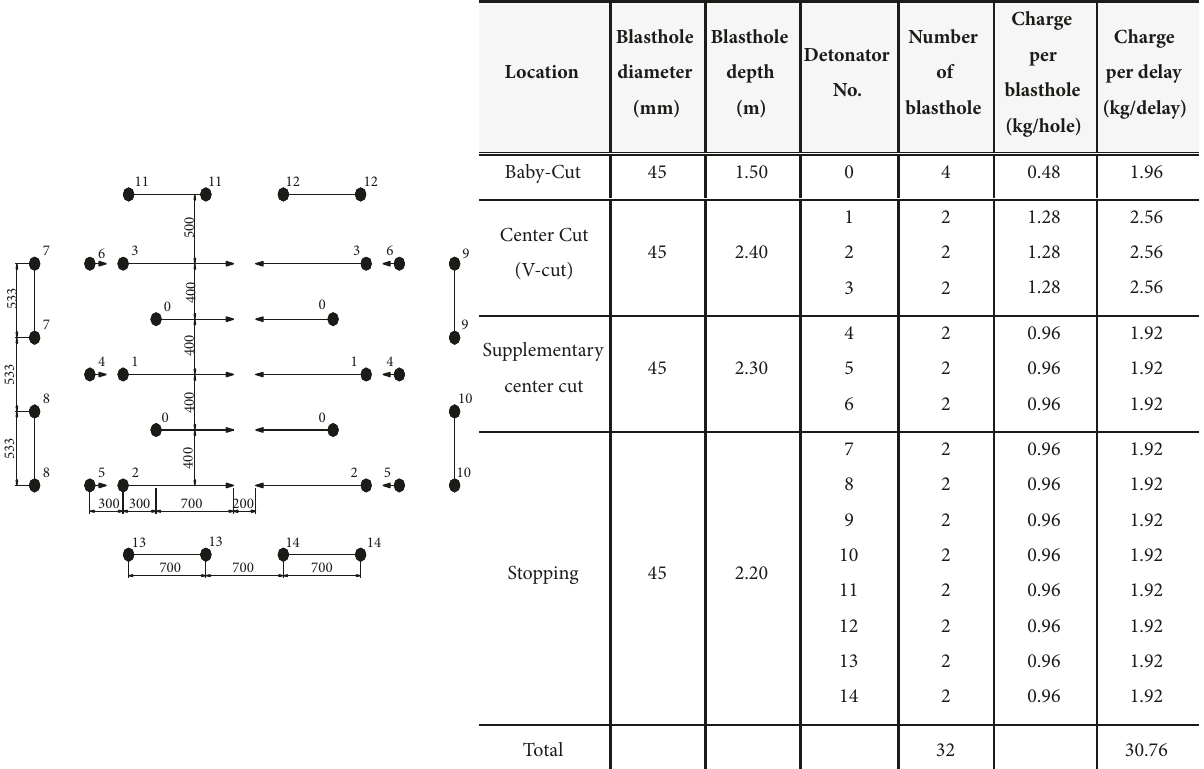
Figure 4: Blasting pattern (V-cut, real scale) (Test #1).